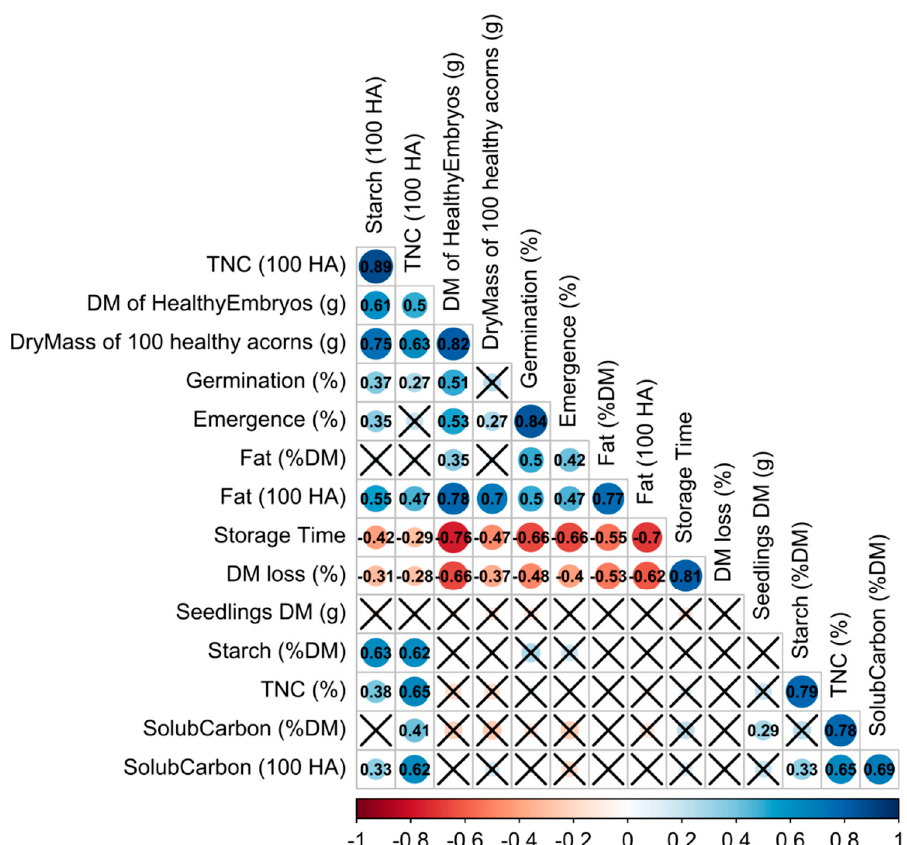
Figure 5. Correlation matrix of evaluated variables. Numbers are Pearson’s correlation coefficients.